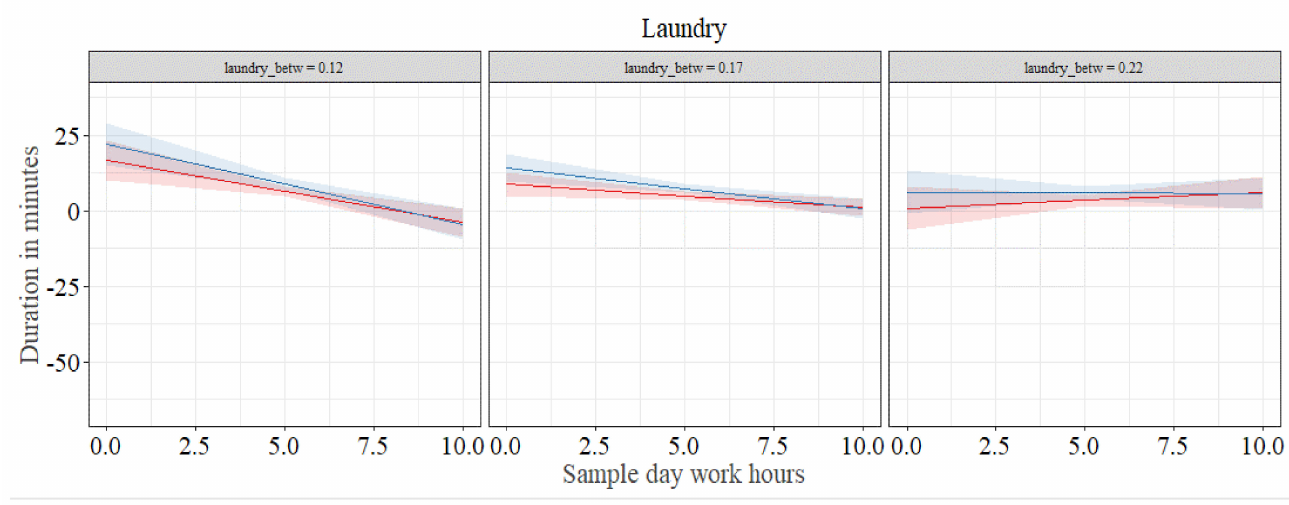
Figure 6. Linear regression lines with significant coefficients for the betweenness centrality metric of regular work patterns (blue line part-time and red line